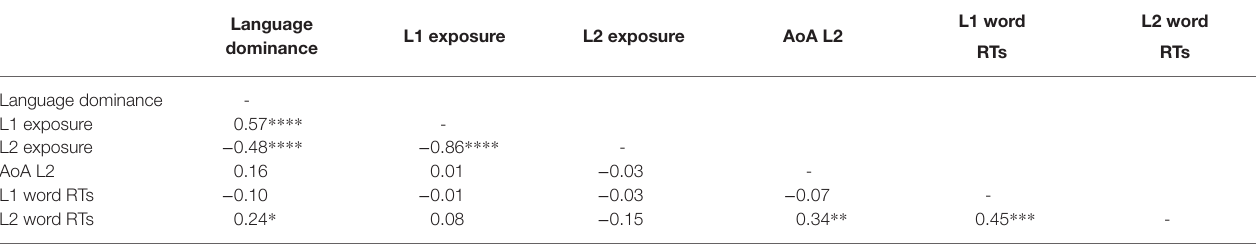
TABLE 6 | Bilinguals’ Pearson correlation analyses between language dominance (dominance), recent exposure, onset age of L2 acquisition (AoA L2), and language recognition performance in response times (RTs) in the lexical decision task. Language